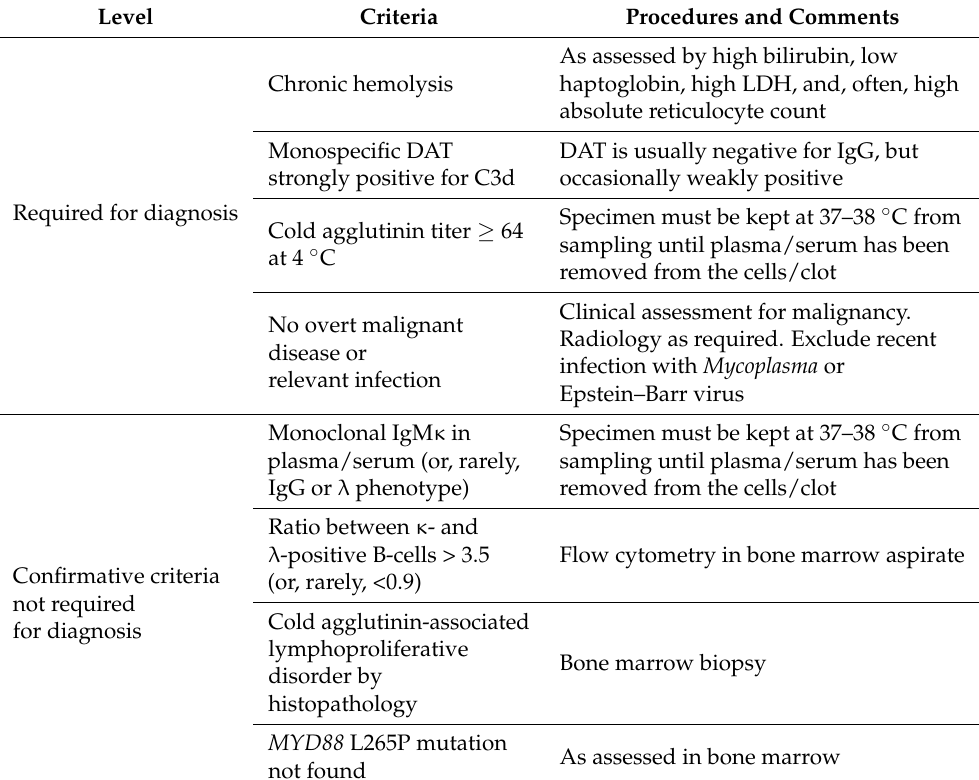
Table 2. Diagnostic criteria for